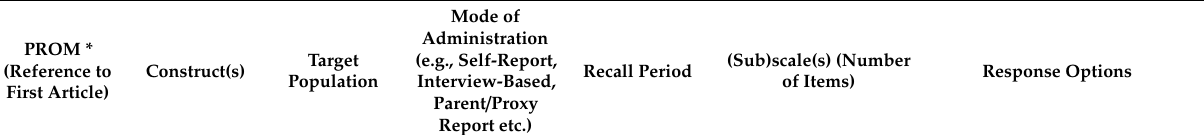
Table 3. Characteristics of the included